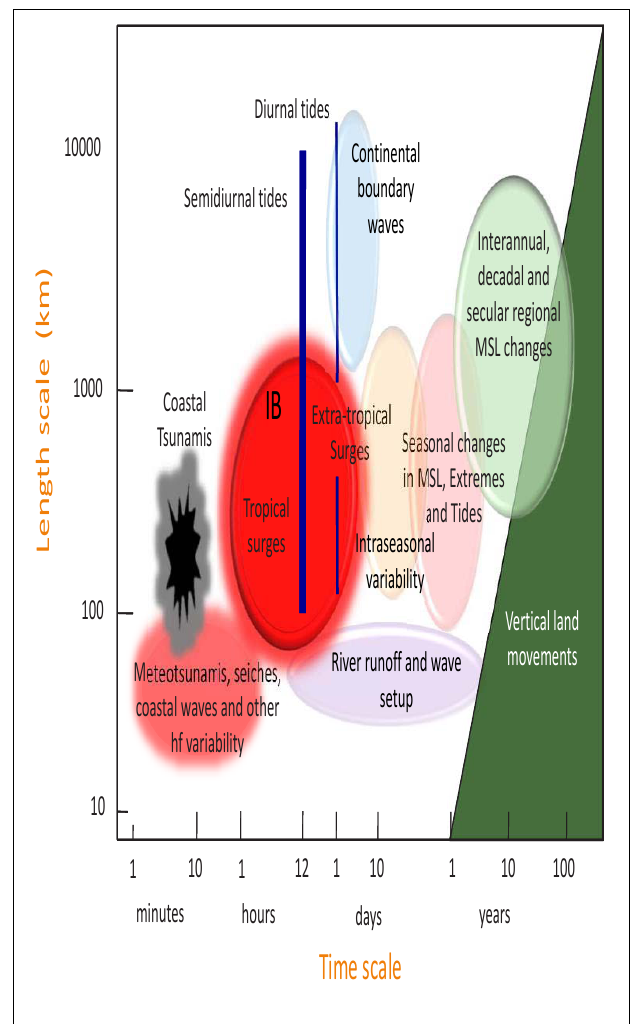
FIGURE 1 | A schematic overview of processes contributing to sea level variability at the coast indicating the space and time scales involved. Woodworth et al. (2019) contains a more complete summary and discussion of each process; Hughes et al. (2019) provides a detailed review of different types of coastal-trapped waves. Very high-frequency processes with timescales less than 1 min (e.g., wind waves, swash) are not included.